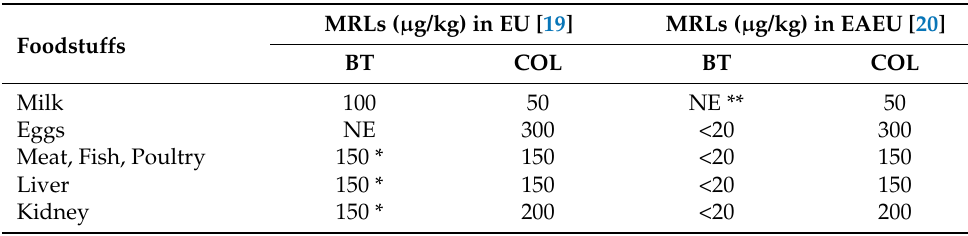
Table 1. Limitations of residual bacitracin (BT) and colistin (COL) content in foodstuff established by the European Union (EU) and the Eurasian Economic Union (EAEU). MRLs ( µ g/kg) in EU [19] MRLs ( µ g/kg) in EAEU [20] Foodstuffs BT COL Milk 100 50 50 Eggs NE 300 <20 300 Meat, Fish, Poultry 150 * 150 <20 150 Liver 150 * 150 <20 150 Kidney 150 *